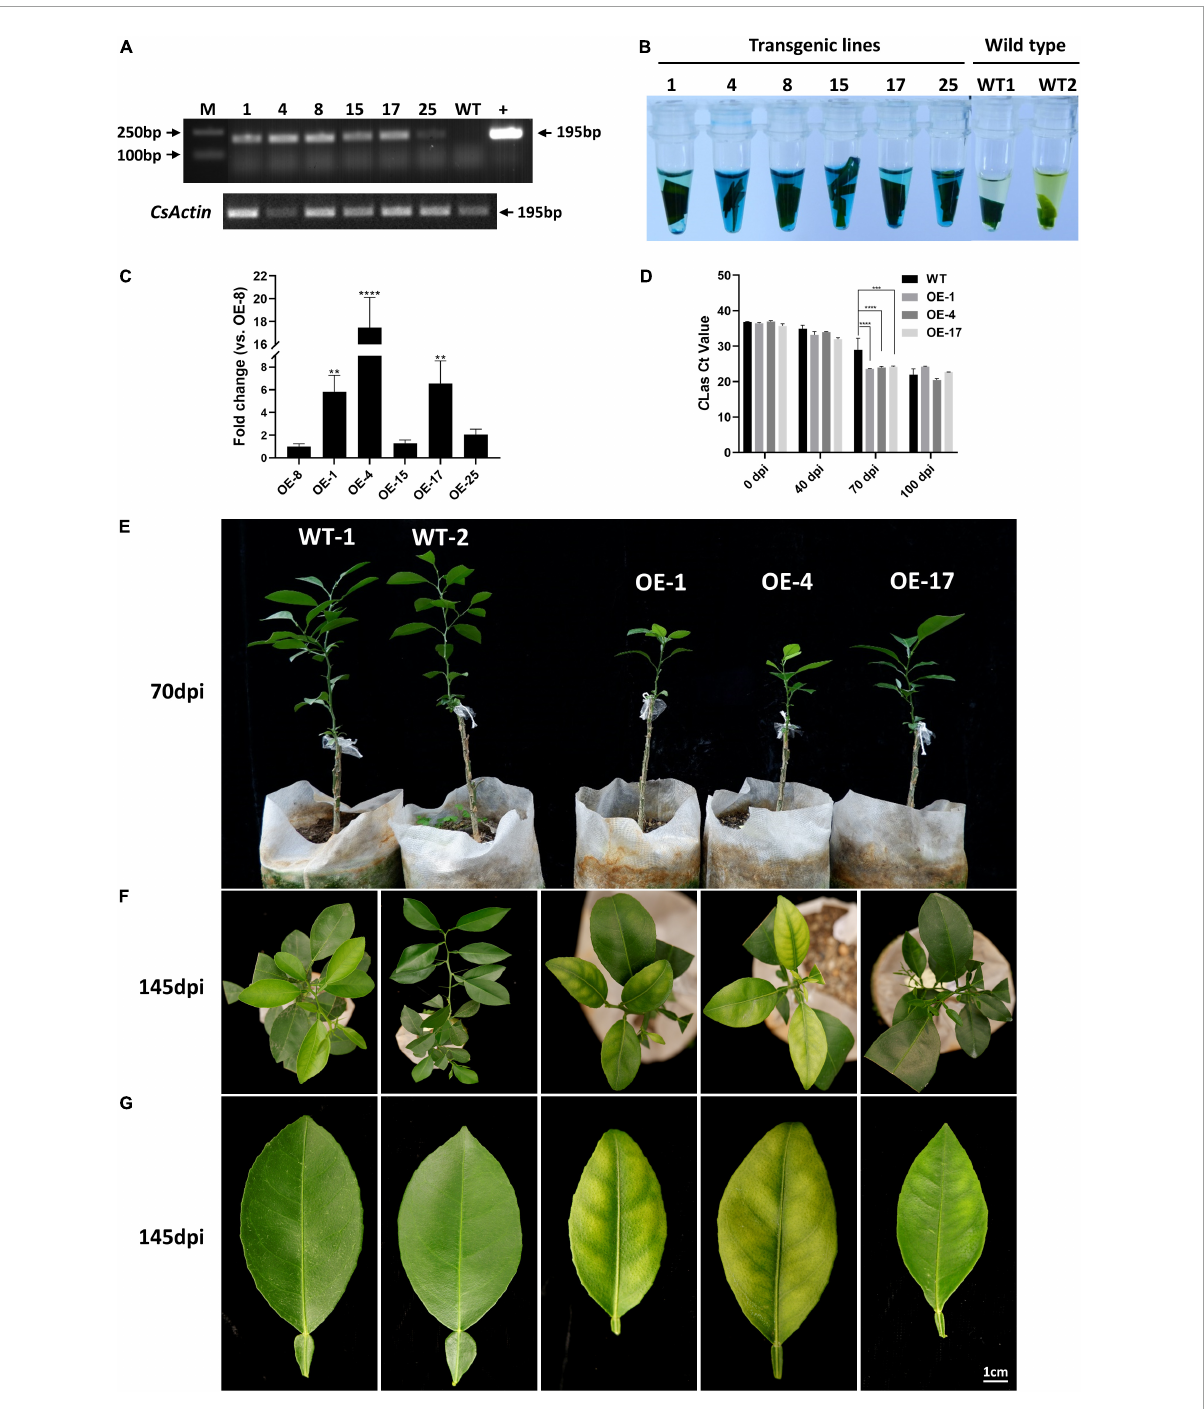
FIGURE4 mSECP8 -transgenic Wanjincheng orange plants were more susceptible to C Las. (A–C) Identification of mSECP8 -transgenic plants. M, DL 2,000 DNA marker; 1, 4, 8, 15, 17, and 25 represented different SECP8 -transgenic lines; WT1 and WT2, wild type of Wanjincheng plants; + , pLGN-mSECP8 plasmid. (A) A 195 bp fragment was detected by RT-PCR using pLGN-mSECP8-F/R primer pairs ( Supplementary Table 1 ), the actin gene of citrus sinensis ( CsActin ) was used as internal reference. (B) Leaves of transgenic plants were used for GUS staining, and the blue-stained indicated positive plants. (C) SECP8 relative expression level in OE-1, OE-4, and OE-15, OE-17, and OE-25 compared with that in OE-8 was determined by RT-qPCR, the CsActin gene was used as internal reference. The asterisks indicate significant difference (** p < 0.01, **** p < 0.0001, determined by one-way ANOVA with Dunnett’s test). (D) The C las titers in the mSECP8 -transgenic citrus and WT control citrus were determined by qPCR at 0, 40, 70, and 100 dpi with C Las, the cytochrome oxidase gene of citrus sinensis ( CsCOX ) was chosen as